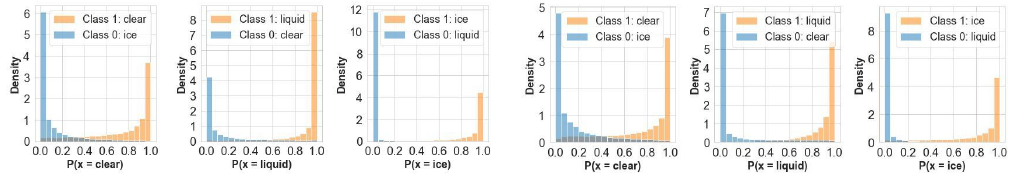
Figure 8. Normalized density functions of the clear, liquid and ice probabilities from the NN model using OvO (one vs. one) strategy comparing all possible two-class combinations of the synthetic MWS validation dataset. Top panels for ocean and bottom panel for land.